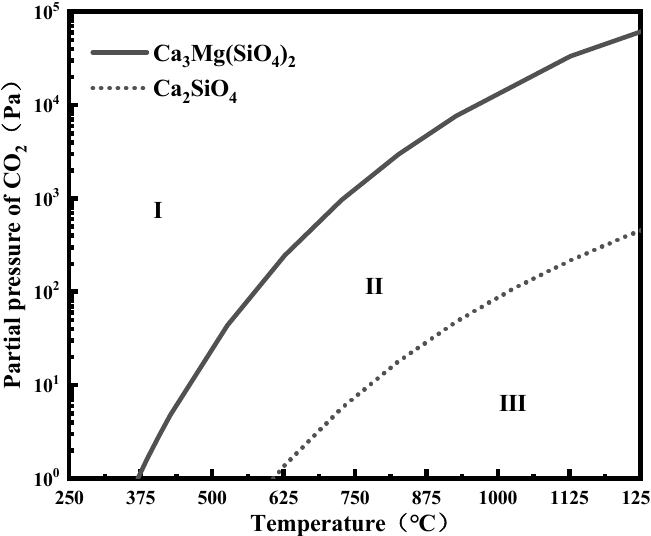
Figure 3. T-P equilibrium diagram of carbonatable phases in the EAF slag (log scale).